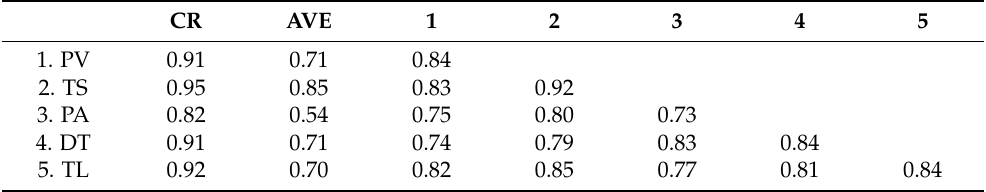
Table 3. CR, AVE, and correlation